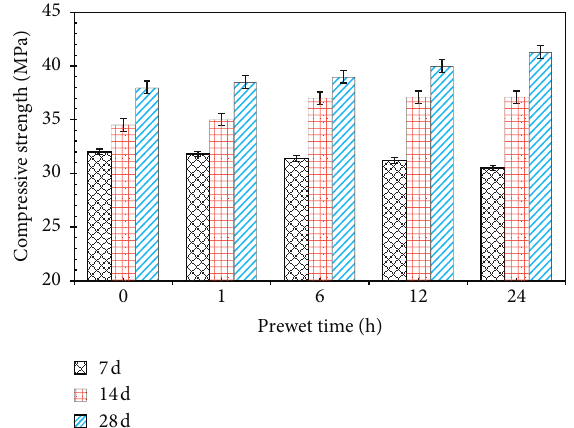
Figure 7: Effect of prewetting time of CGC on the compressive strength of the concrete.